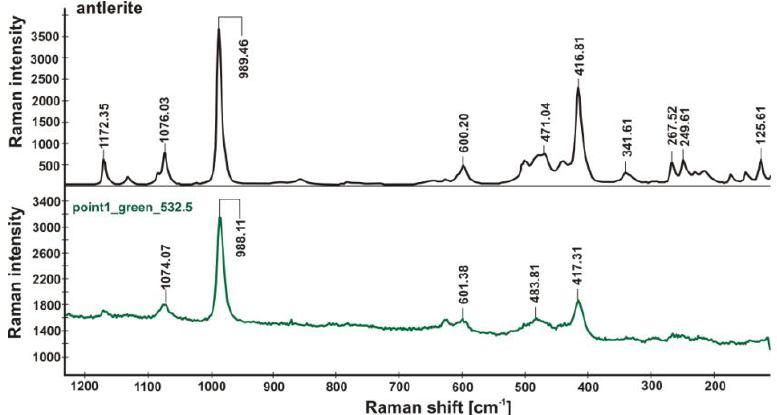
Figure 20. Comparison of the Raman spectrum of antlerite Cu the Raman spectrum of green corrosion layer shown in Figure 18 (lower plot).